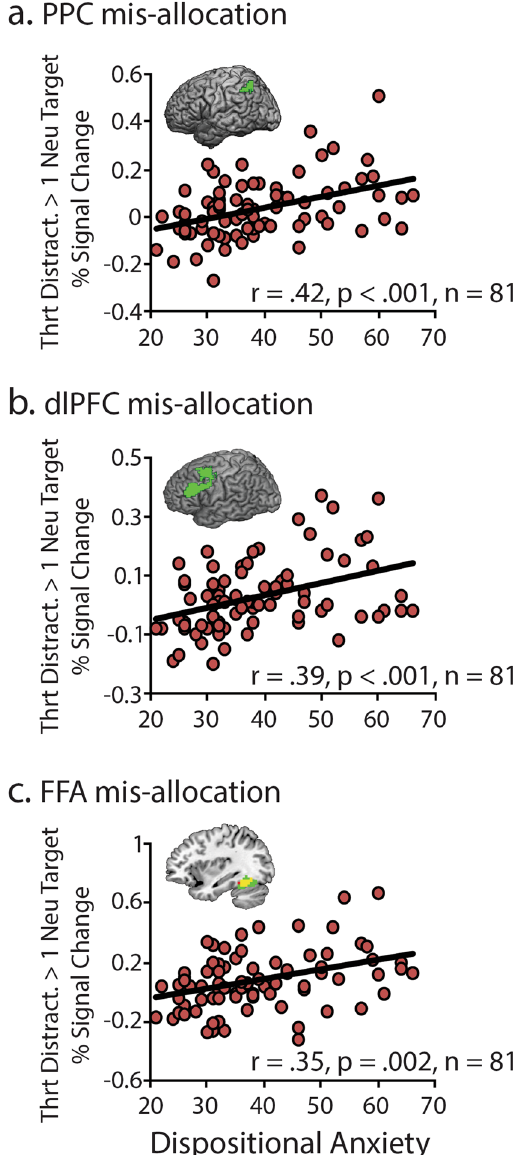
Figure 3. Dispositional anxiety predicts the mis-allocation of WM to threat-related distracters. Mis-allocation scores were defined as the difference in activation associated with the presence of a distracter (e.g., Neutral Target + Threat-Related Distracter minus Neutral Target). Larger scores indicate greater allocation of WM resources to threat-related distracters. Analyses revealed that higher levels of dispositional anxiety are associated with increased mis-allocation of WM to threat-related distracters in the ( a ) PPC, ( b ) dlPFC, and ( c ) FFA